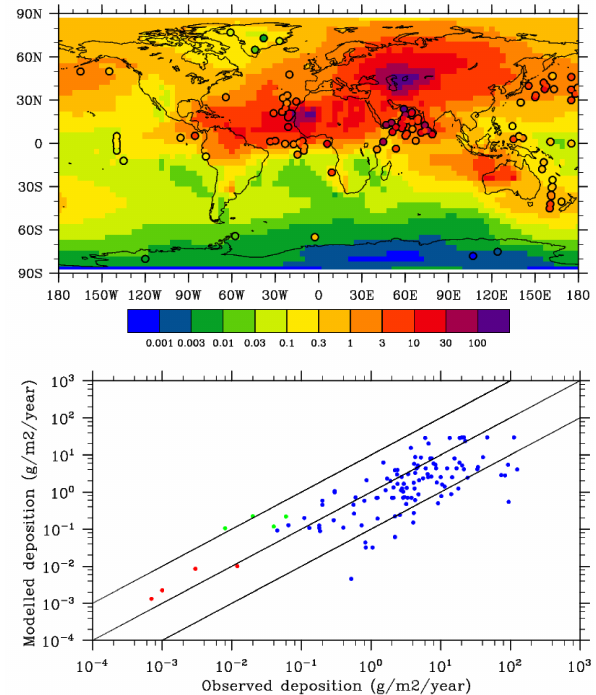
Figure 2. Top: simulated dust deposition flux (gm − 2 yr − 1 ) for the pre-industrial time slice compared with dust deposition data com- piled from ice cores, marine sediment traps and marine sediment cores (gm − 2 yr − 1 ; circles). Bottom: scatter plot comparing mod- elled and observed deposition. Red indicates Antarctica, green indi- cates Greenland and blue indicates other